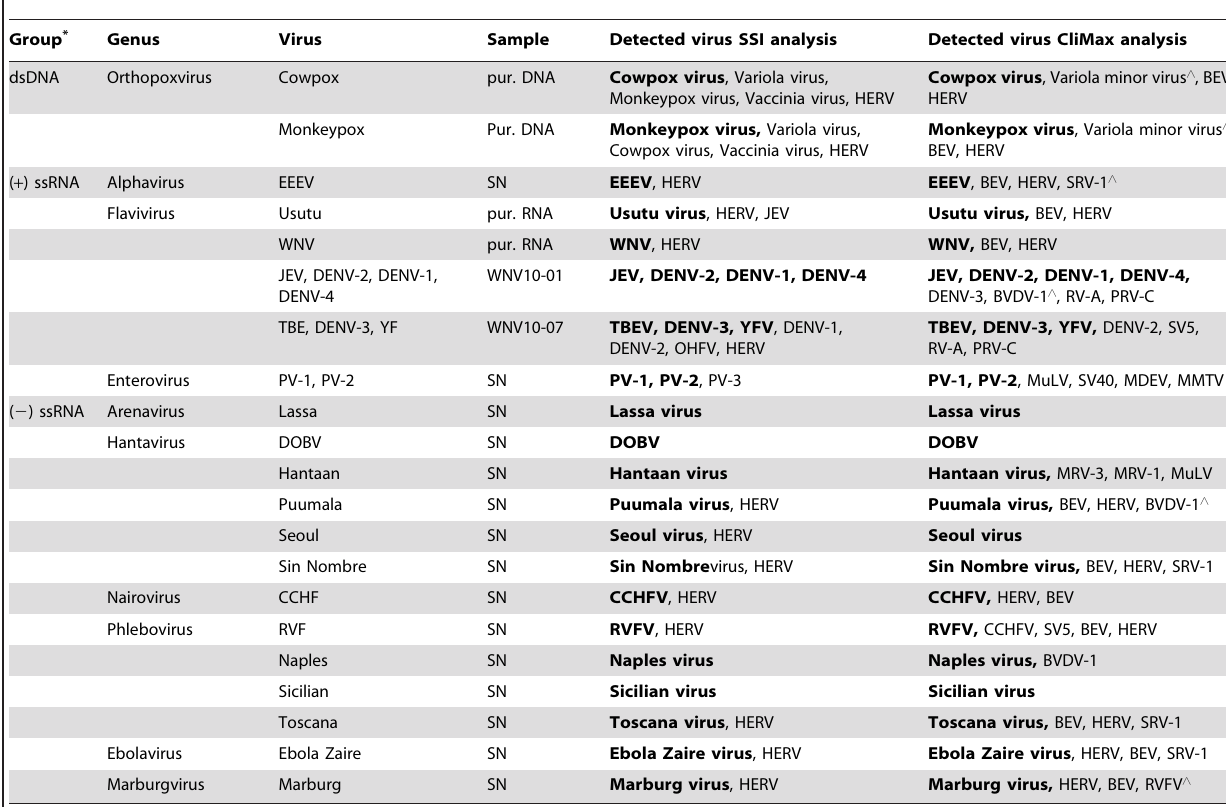
Table 2. Microarray results on non-clinical samples using two different data analysis